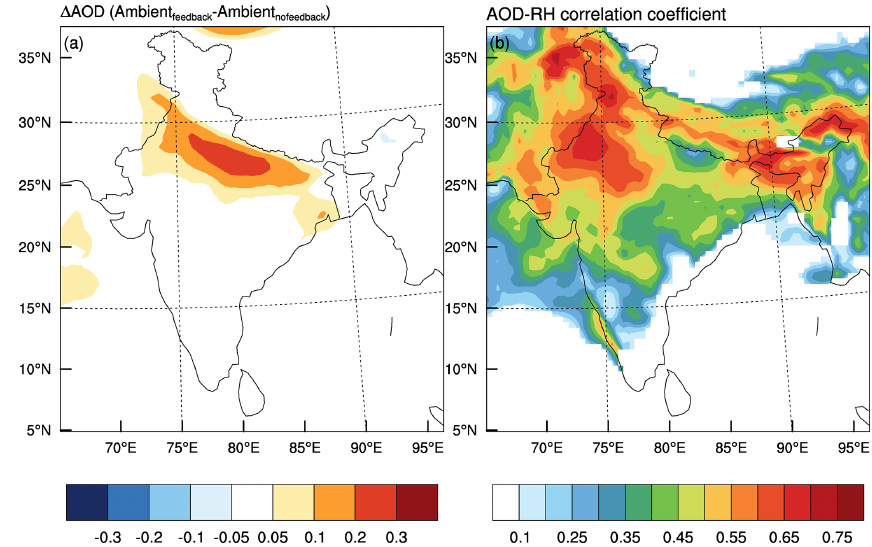
Figure 8. (a) Change in AOD due to the meteorological feedbacks of the hygroscopic growth of aerosols ((Ambient feedback − Dry feedback ) − (Ambient − Dry nofeedback nofeedback ) ). (b) Correlation coefficient of AOD and relative humidity due to the meteorological feedback of hygroscopic growth of